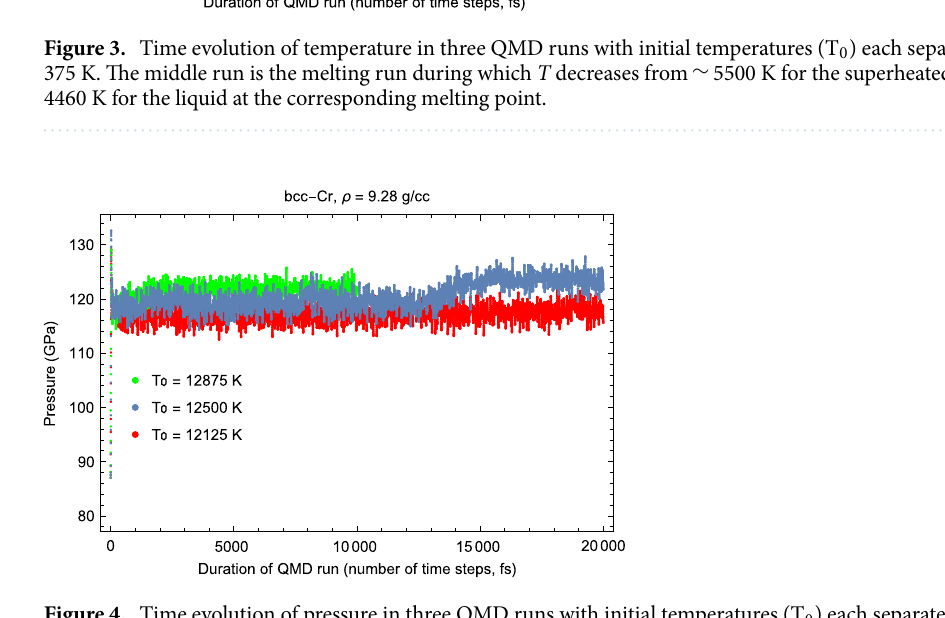
Figure 4. Time evolution of pressure in three QMD runs with initial temperatures (T 0 ) each separated by 375 K. During melting P increases from 120 GPa for the superheated state to 124 GPa for the liquid at the ∼ corresponding melting